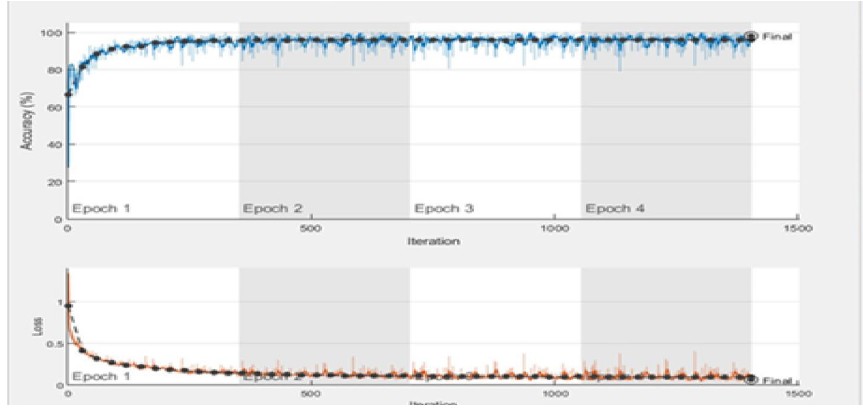
Fig. 6 The results of network training